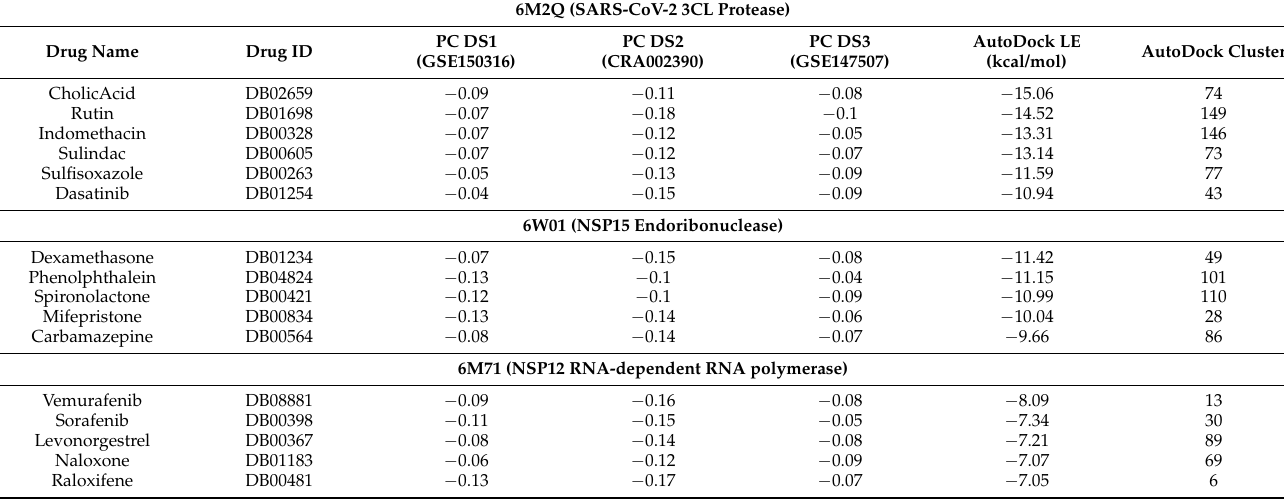
Table 2. Drug repurposing candidates based on the topological, trascriptomic, and docking criteria. PC: Pearson correlation. LE: Lowest energy conformation in the cluster. Candidates with a PC of < − 0.1 may revert the transcriptomic effects of SARS-CoV-2 infection. The maximum number of the AutoDock cluster is 150. Drug ID (colum 2) encodes the DrugBank ID of the corresponding drug (column